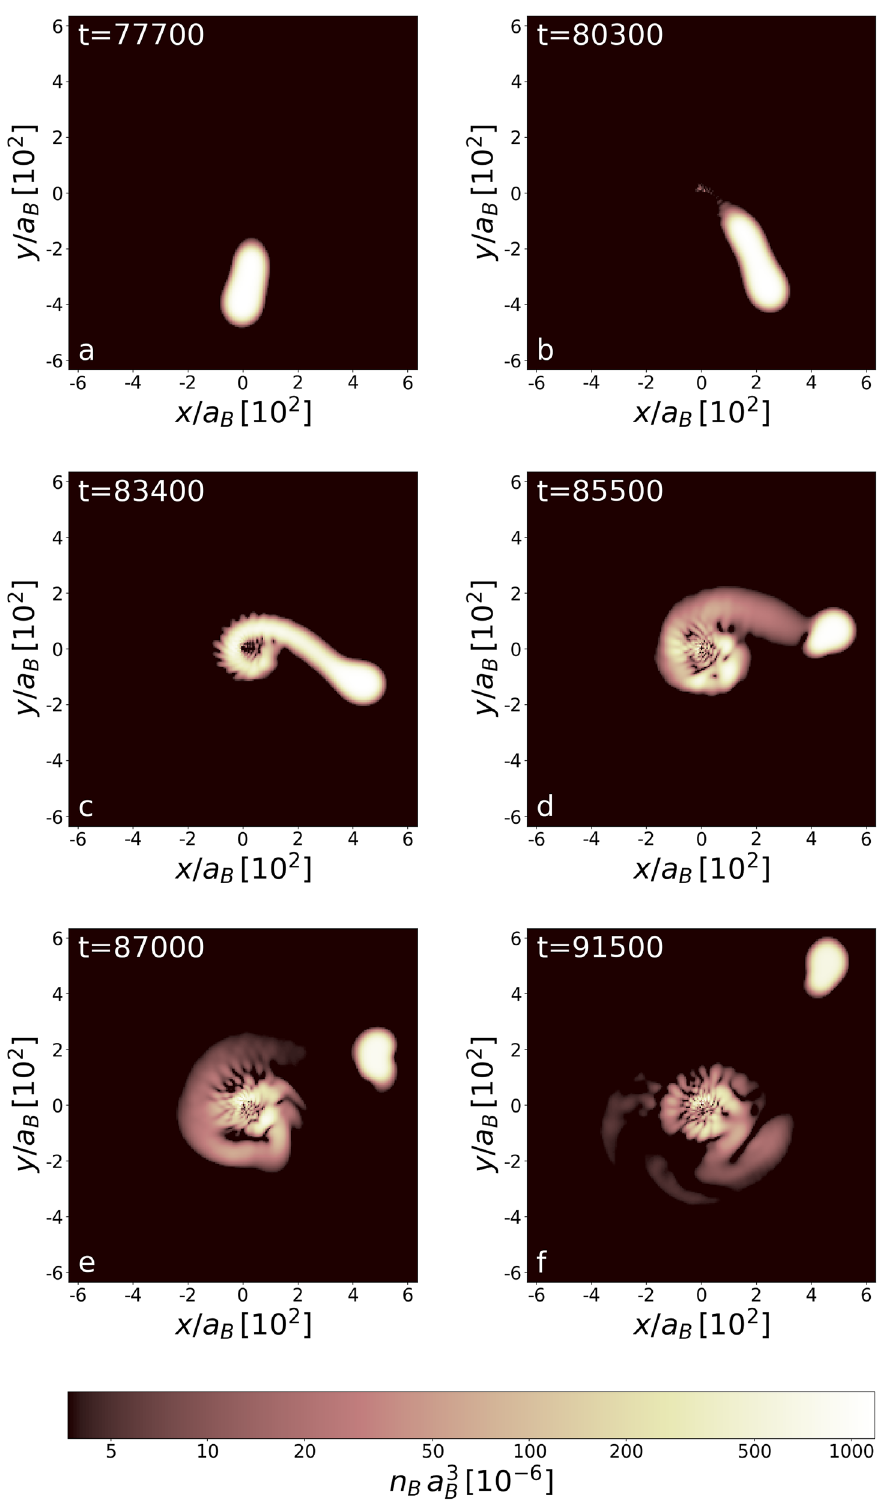
0 plane) of bosonic component at times during (frames a – c ) and after Figure 3. Density distribution (at z = (frames e , f ) the third-time periastron passage for the first considered orbit. The unit of time is ( m B a atomic white dwarf is stripped of about 10% of its initial mass. The stripped mass (both of bosonic and fermionic type) forms a massive accretion disk. Frames show densities during the third revolution. The binary system ends its life and the white dwarf goes away of the black